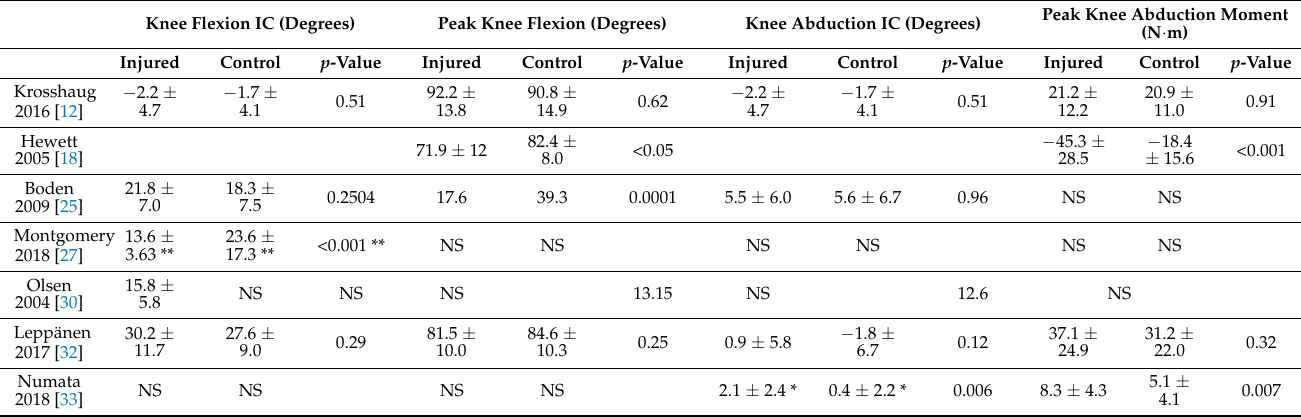
Table 3. Knee Flexion Angle Values of Studies